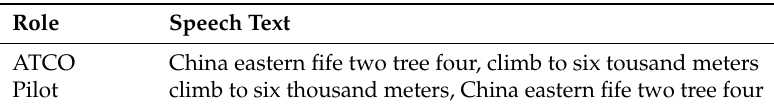
Table 1. Example of ATC